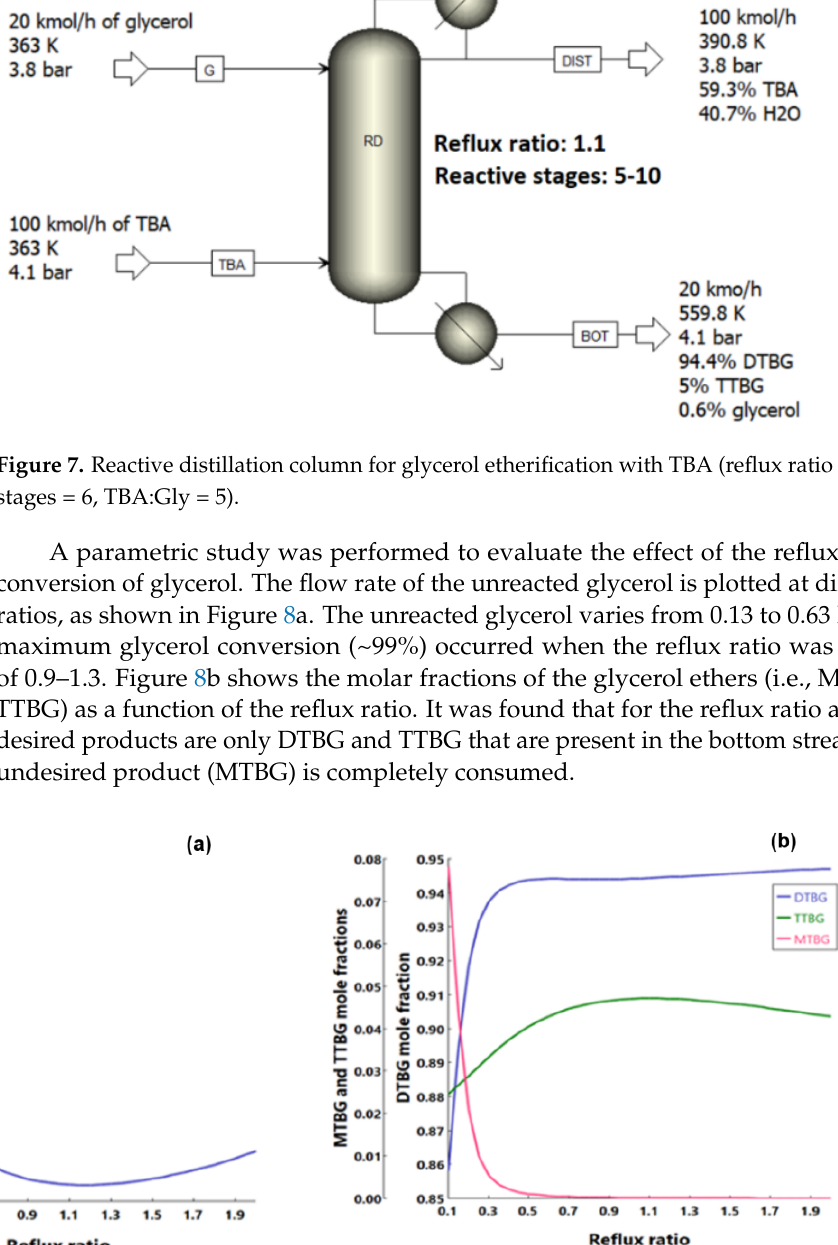
Figure 8. For reactive stages = 6, TBA: Gly = 5, ( a ) unreacted glycerol flow rate as a function of the reflux ratio, and ( b ) glycerol ether compositions in the bottom stream as a function of the reflux ratio.